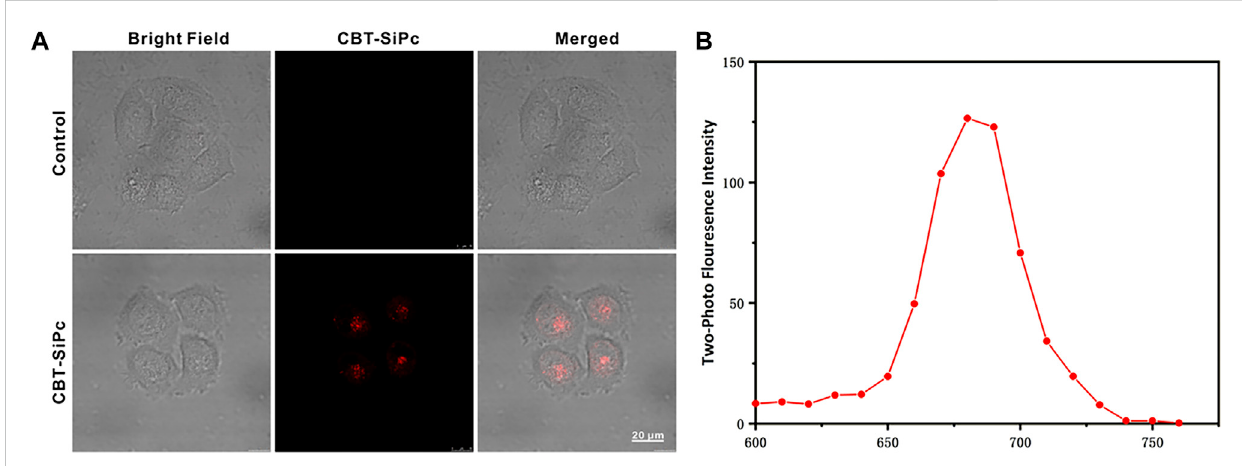
FIGURE 2 Two-photon fl uorescence images of CBT-SiPc in MCF-7 breast cancer cells. (A) Two-photon fl uorescence images of CBT-SiPc in MCF-7 breast cancer cells (2 μ M, red fl uorescence, excitedby860 nm fs laser. The fl uorescence was monitored at650 – 700 nm). (B) Confocal lambda